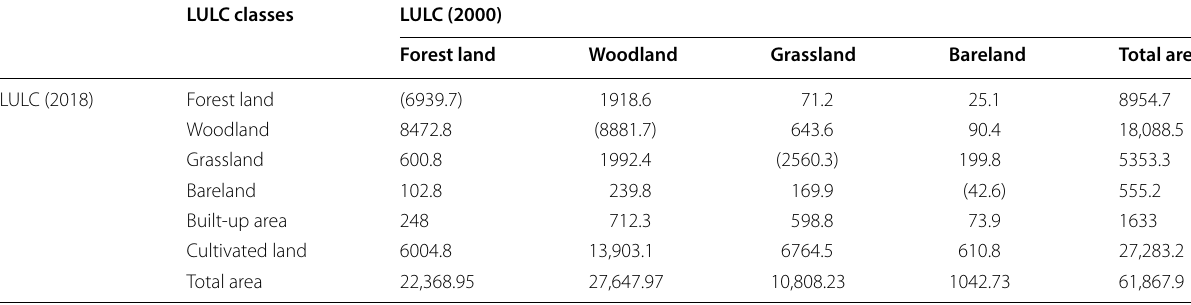
Numbers in the parenthesis indicates the unchanged values in land use/cover